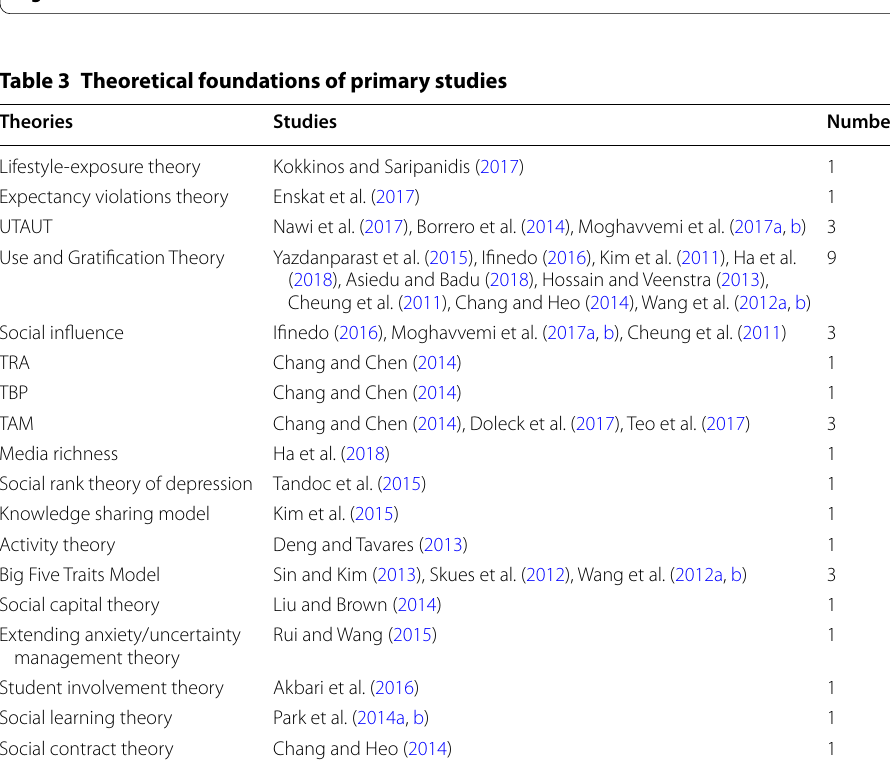
Fig. 6 Research method distribution